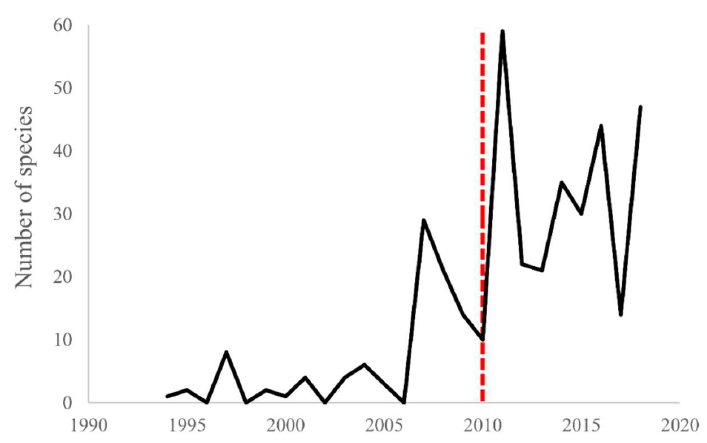
Figure 1. Evidence for the impact of high-throughput sequencing on the number of bird species genotyped for MHC, as demonstrated by the increase in the number of bird species genotyped for MHC each year since 2010 (red dashed line) when the first studies using high-throughput sequencing for avian MHC genotyping were published. Figure prepared using data from Minias et al. 2018 [103] with updated information added for studies until the end of 2018 using identical methods to those described within Minias et al 2018 [103].